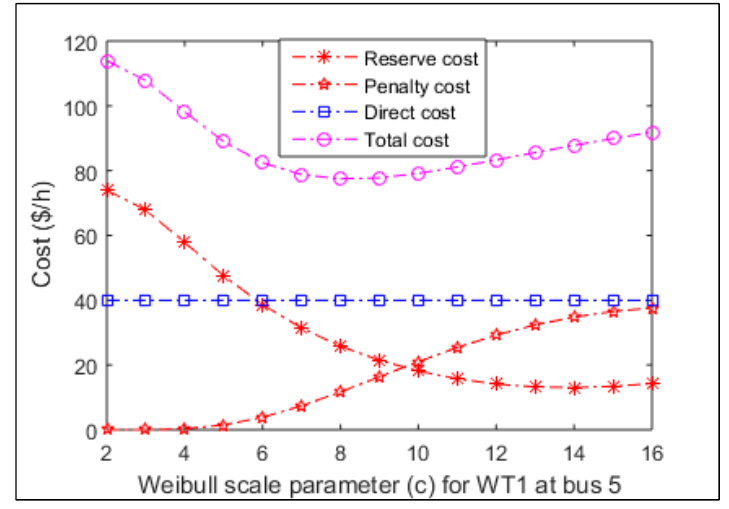
Figure 7. Cost vs. Weibull scale parameter ( c ) at bus #5.